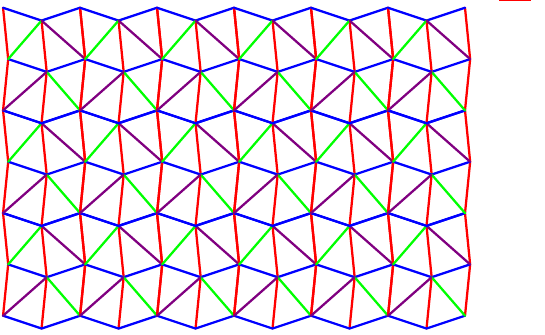
Fig. 17: Tiling with two types of triangles: one is non-isosceles and one is isosceles (NC).